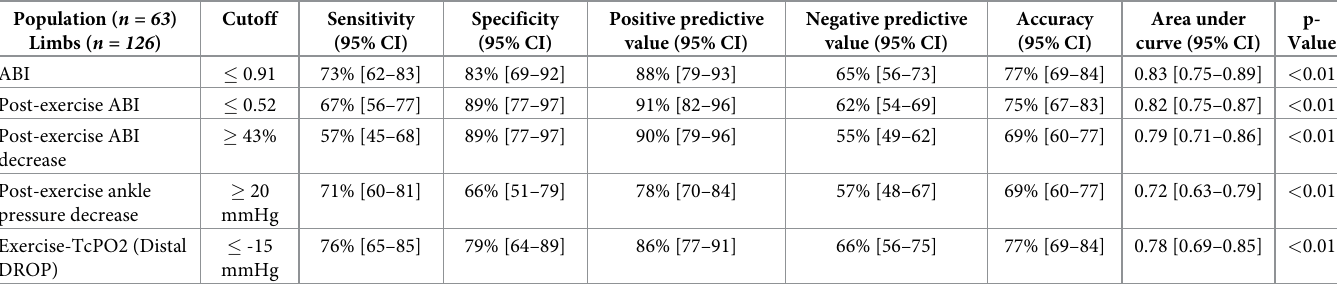
Table 3. Test characteristics for identifying stenosis � 50% in any limb from aorta till popliteal artery in the overall population ( n = 126 limbs ). Population ( n = 63 ) Limbs ( n = 126